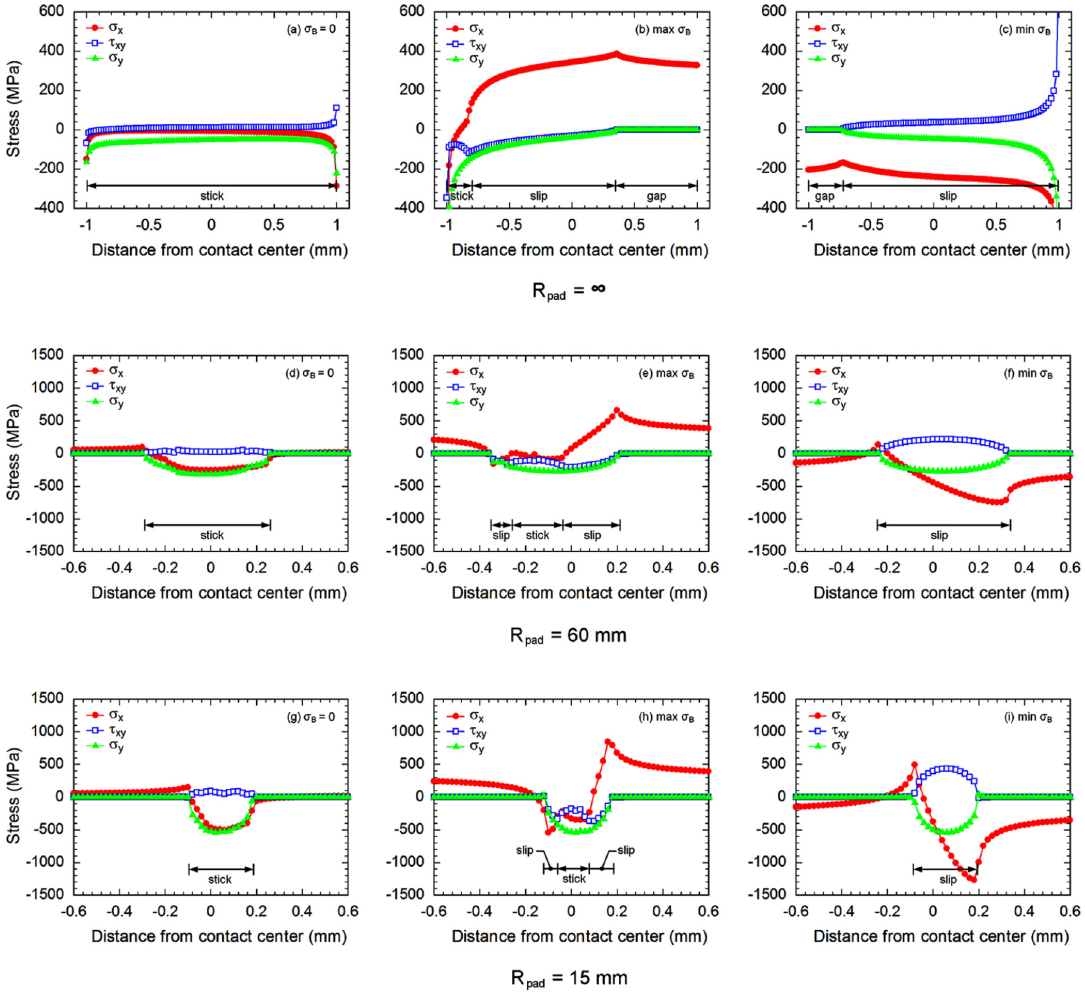
Figure 6. Stresses along contacts of fretting fatigue experiments at a stress amplitude of 300 MPa: ( a – c ) R pad = ∞ , ( d – f ) R pad = 60 mm, and ( g – i ) R pad = 15 mm.